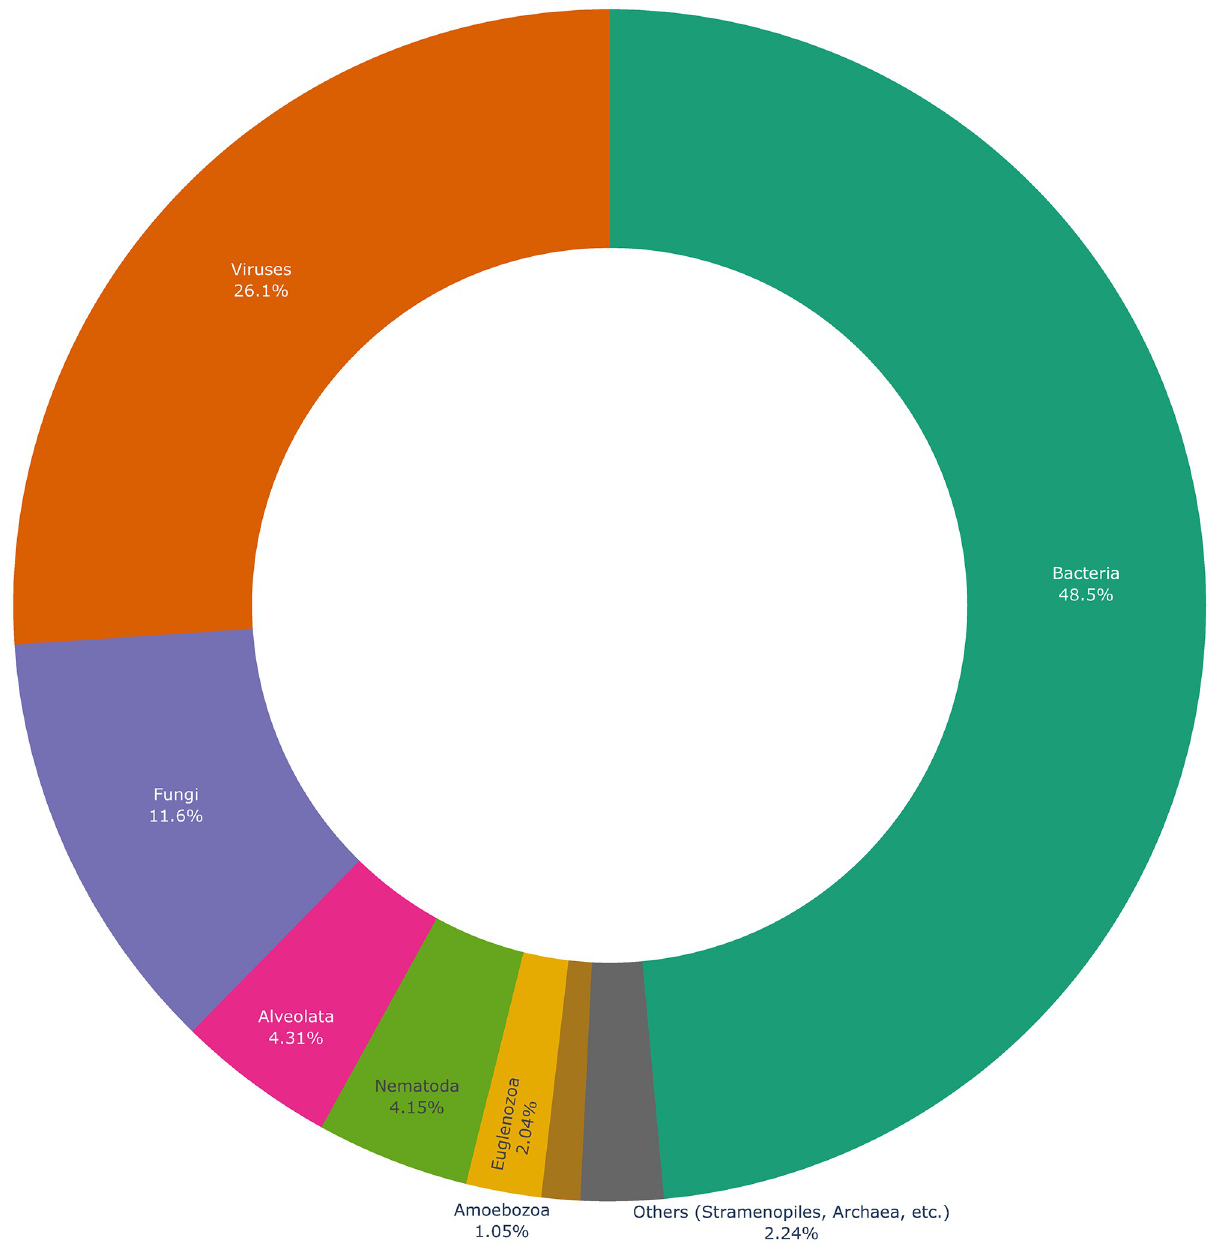
Fig 5. Distribution of microbe taxa in Lives_In relations extracted from PubMed in Omnicrobe. The taxa represented in this chart are taxon roots selected as microorganisms in Omnicrobe (see section Ontologies and taxonomies). The arc is proportional to the number of Lives_In relations that involve the taxon or any descendant. “Others” include taxa that account for less than 1% of relations: Archae , Chlamydomonadales , Chlorella , Choanoflagellida , Cryptophyta , Desmidiales , Diplomonadida , Glaucocystophyceae, Haptophyta , Ichthyosporea , Oxymonadida , Parabasalia , Prototheca , Retortamonadidae , Rhizaria